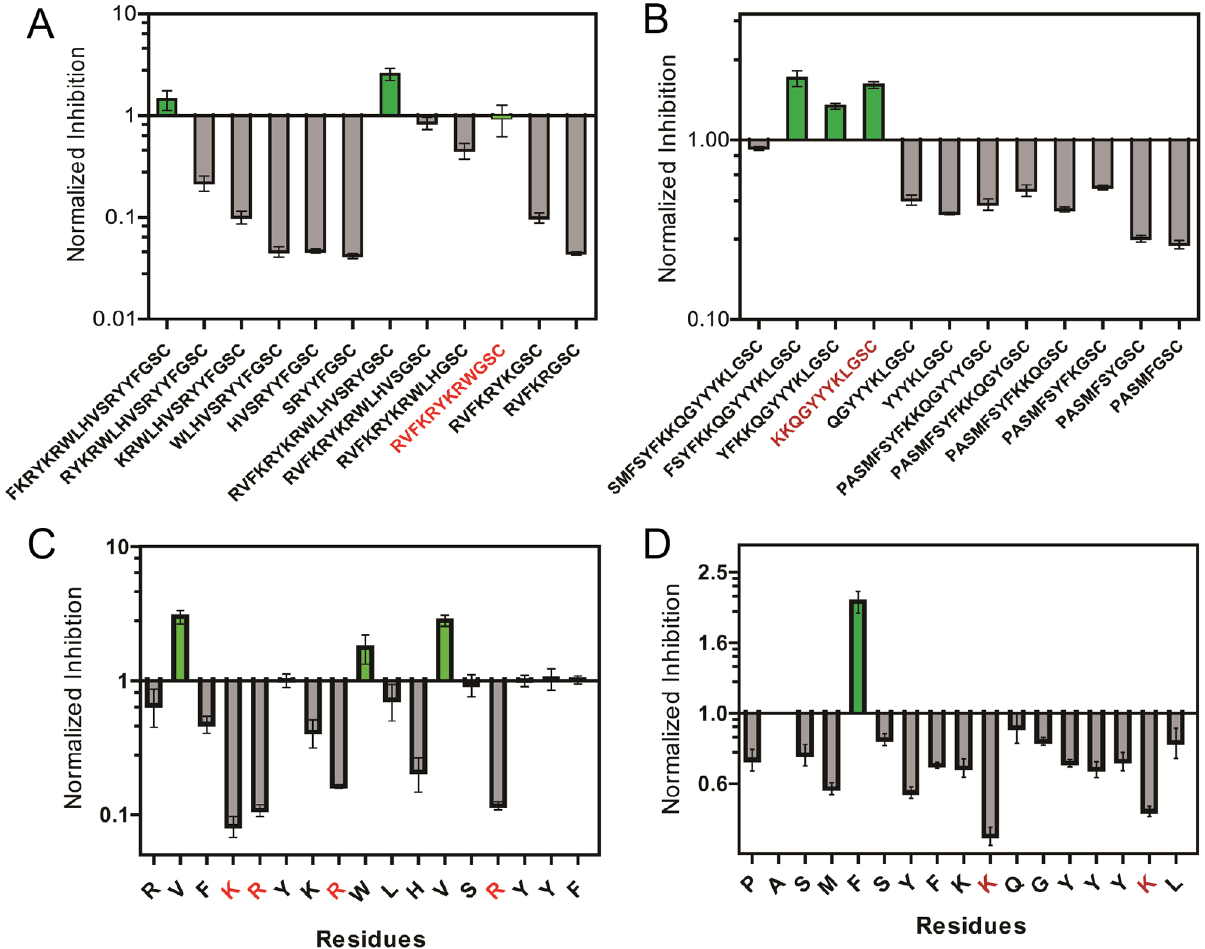
Fig 3. Sequential truncation and alanine scan of PEP-1 and PEP-2 for inhibiting β -Gal activity. (A) Truncation scans of PEP-1 and (B) PEP-2 for inhibiting β -Gal. (C) Alaninescans of PEP-1 and (D) PEP-2 for inhibiting β -Gal. All inhibitionsof alanine-substituted peptides and truncated peptides were normalized to the inhibition percentagevalues of PEP-1 at 10 μ M and PEP-2 at 50 μ M, respectively. All tests includedthree replicates. Error bar: range of data.